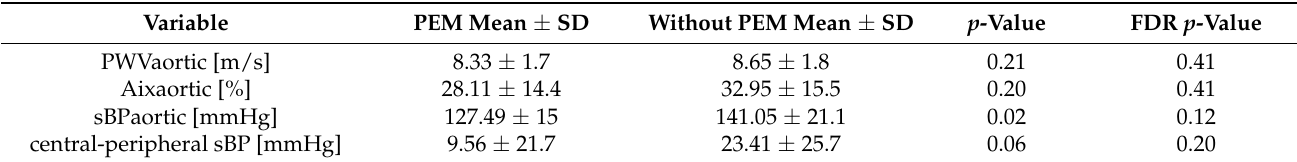
Table 2. Comparison of arteriography results of patients with PEM and without